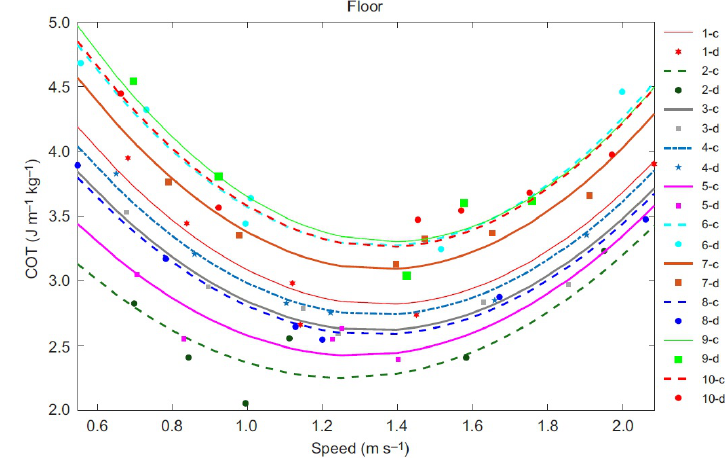
Fig. 1 The trajectory of the limbs of the same subject walking at different speeds.